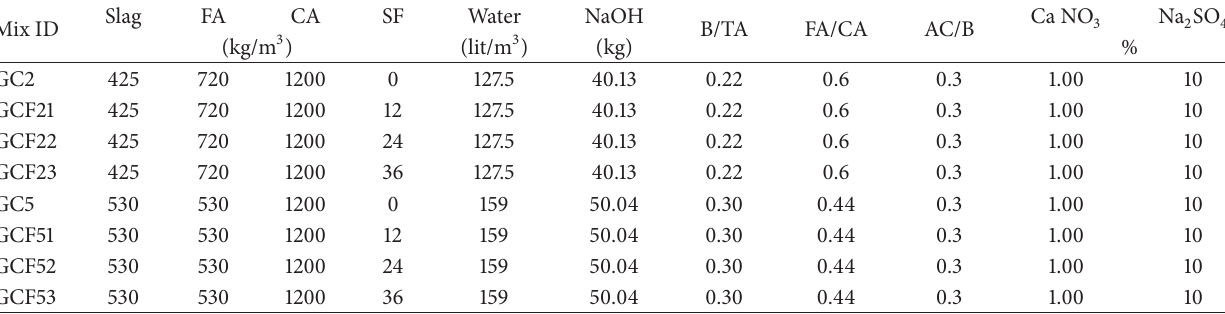
Table 5: Dosage of steel fibre in slag based geopolymer concrete.